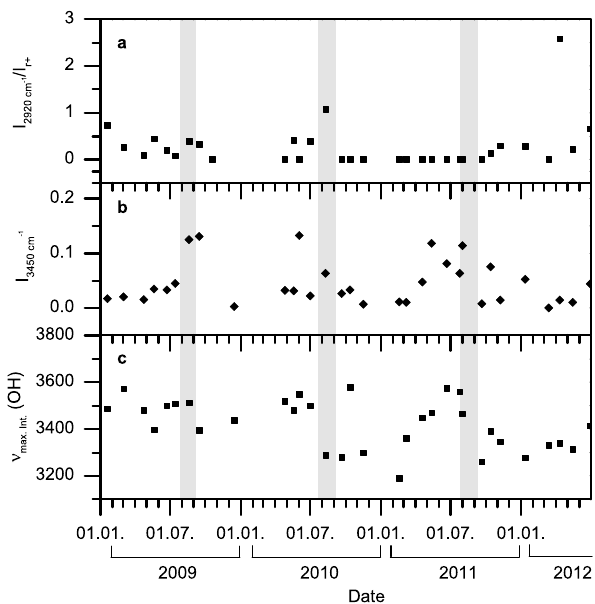
Fig. 3. Carbohydrate indications in spectral trends. (a) Relative in- tensity of the CH mode at 2920cm − 1 , (b) intensity of the OH bond band at 3450cm − 1 , and (c) wavenumber of maximum intensity of the OH bond band. The grey areas highlight the samples taken in August (see discussion in section